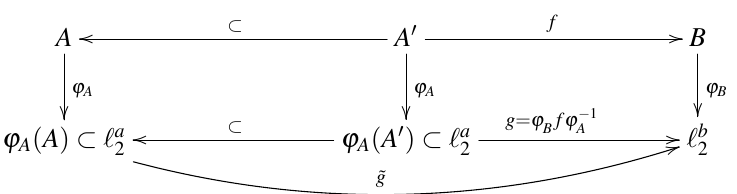
Figure 2: Commutative diagram for maps g and ˜ g